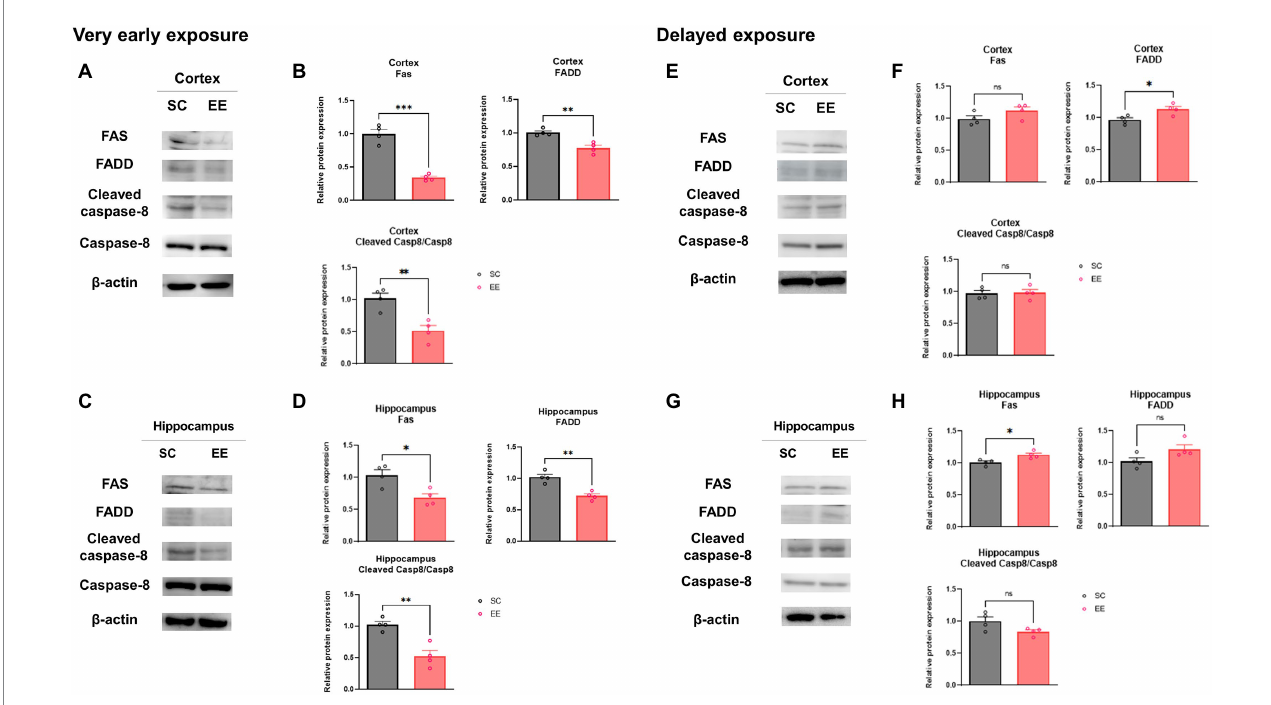
FIGURE 7 Effects of very early and delayed exposure to EE on protein expression in the extrinsic apoptosis pathway in the cerebral cortex and the hippocampus. (A,C) Representative WB images from cerebral cortex (A) and hippocampus (C) obtained after very early EE exposure. (B,D) Quantification of Fas, FADD, and cleaved Caspase-8 levels in the cerebral cortex (B) and the hippocampus (D) ( n = 4 per group). (E,G) Representative WB images from cortical (E) and hippocampus (G) obtained after delayed EE exposure. (F,H) Quantification of Fas, FADD, and cleaved Caspase-8 in the cerebral cortex (F) and hippocampus (H) ( n = 4 per group). All statistical comparisons were performed via Student’s t -tests. Data represented are means ± SEM. * p < 0.05, ** p < 0.01, and *** p < 0.001. EE, environmental enrichment; WB, western